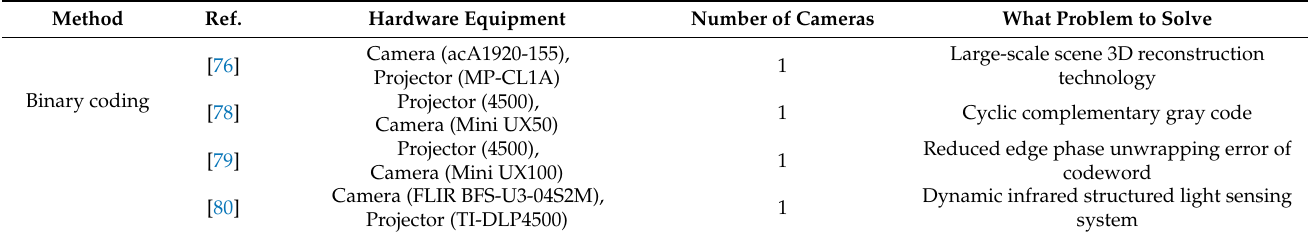
Table 6. Binary coding.